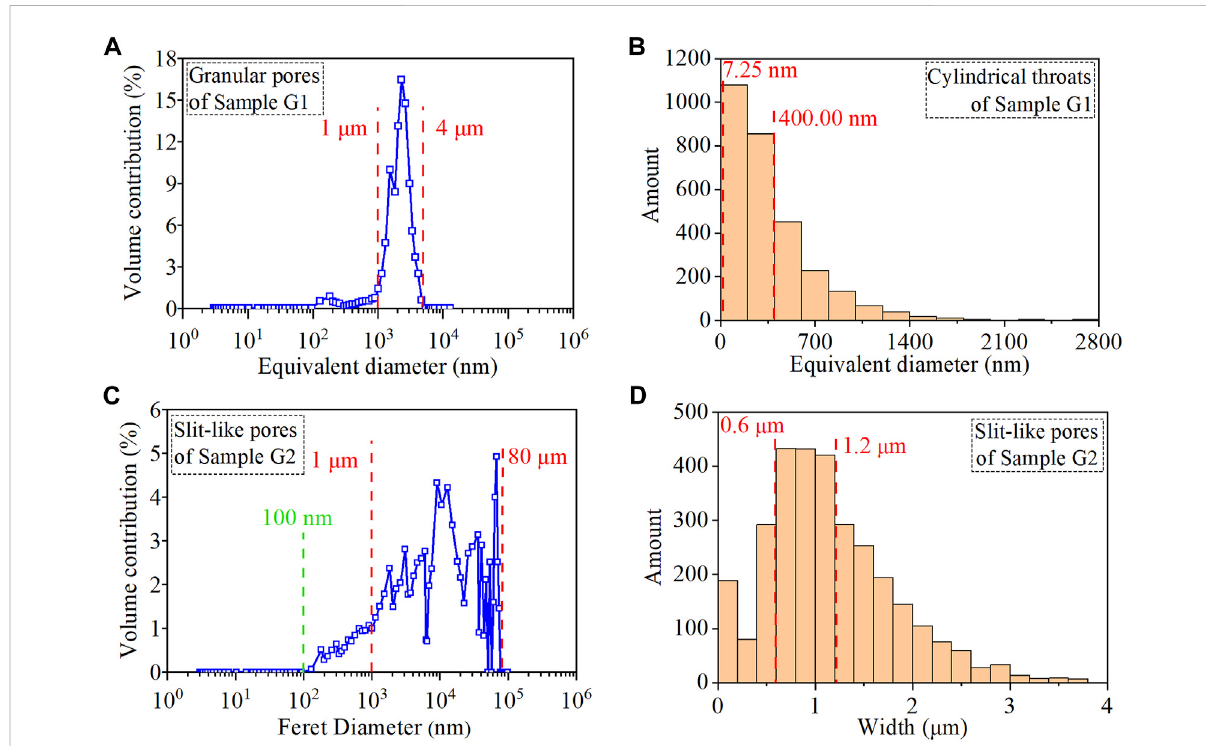
FIGURE 3 Quantitative analysis of LV-FIB-SEM 3D pore-network models. (A) Volume contribution distribution of granular pores and (B) diameter distribution of cylindrical pore throats of Sample G1; (C) volume contribution distribution of slit-pores and (D) width distribution of slit-pores of Sample